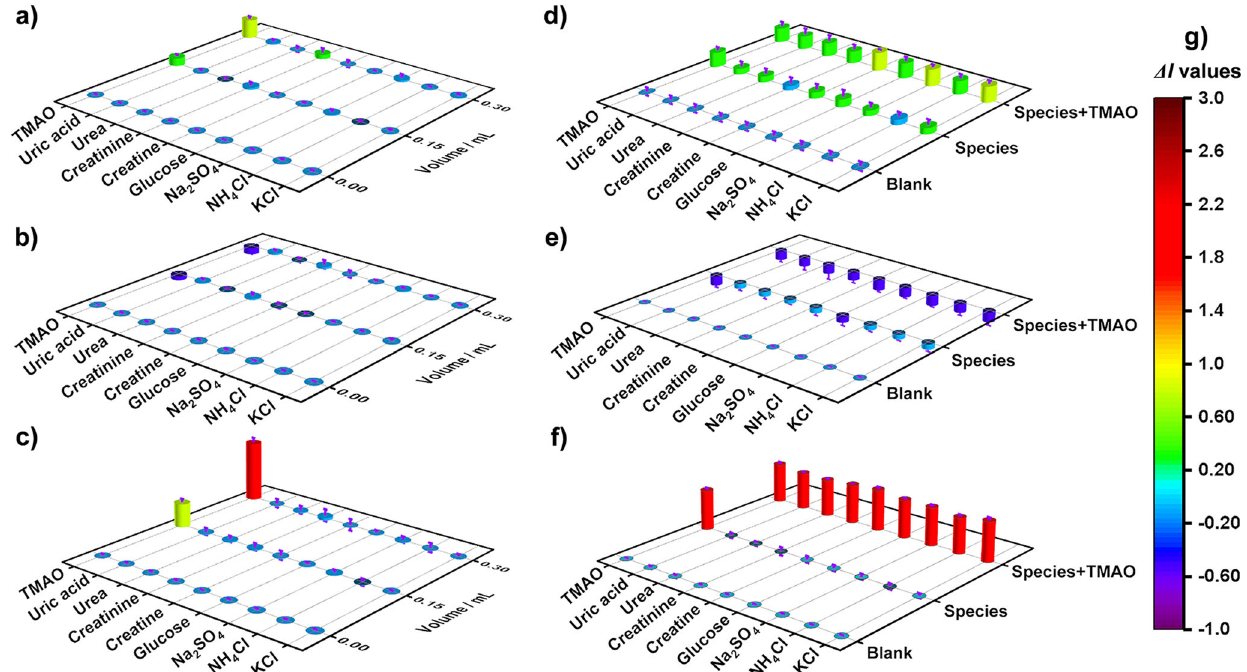
Fig. 3 Selectivity and anti-interference ability of B7. Selectivity of B7 aqueous dispersions towards TMAO (3.25 mM) in common urine disruptors based on the change of luminescent intensities at 544 nm a , 616 nm b , and the ratio of I 616 / I 544 c , respectively. Anti-interference ability of B7 aqueous dispersions in common urine disruptors without/with 3.25 mM TMAO based on the change of luminescent intensities at 544 nm d or 616 nm e , and the ratio of I 616 / I 544 f , respectively. g Indication by the colormap. The concertation of creatine, creatinine glucose, uric acid, urea, KCl, NH 4 Cl and Na 2 SO 4 was 1.33, 1.33, 1.33, 0.16, 1.33, 2.67, 2.67 and 1.33 mM, respectively. Error bar shows the standard deviation of three consecutive test values.